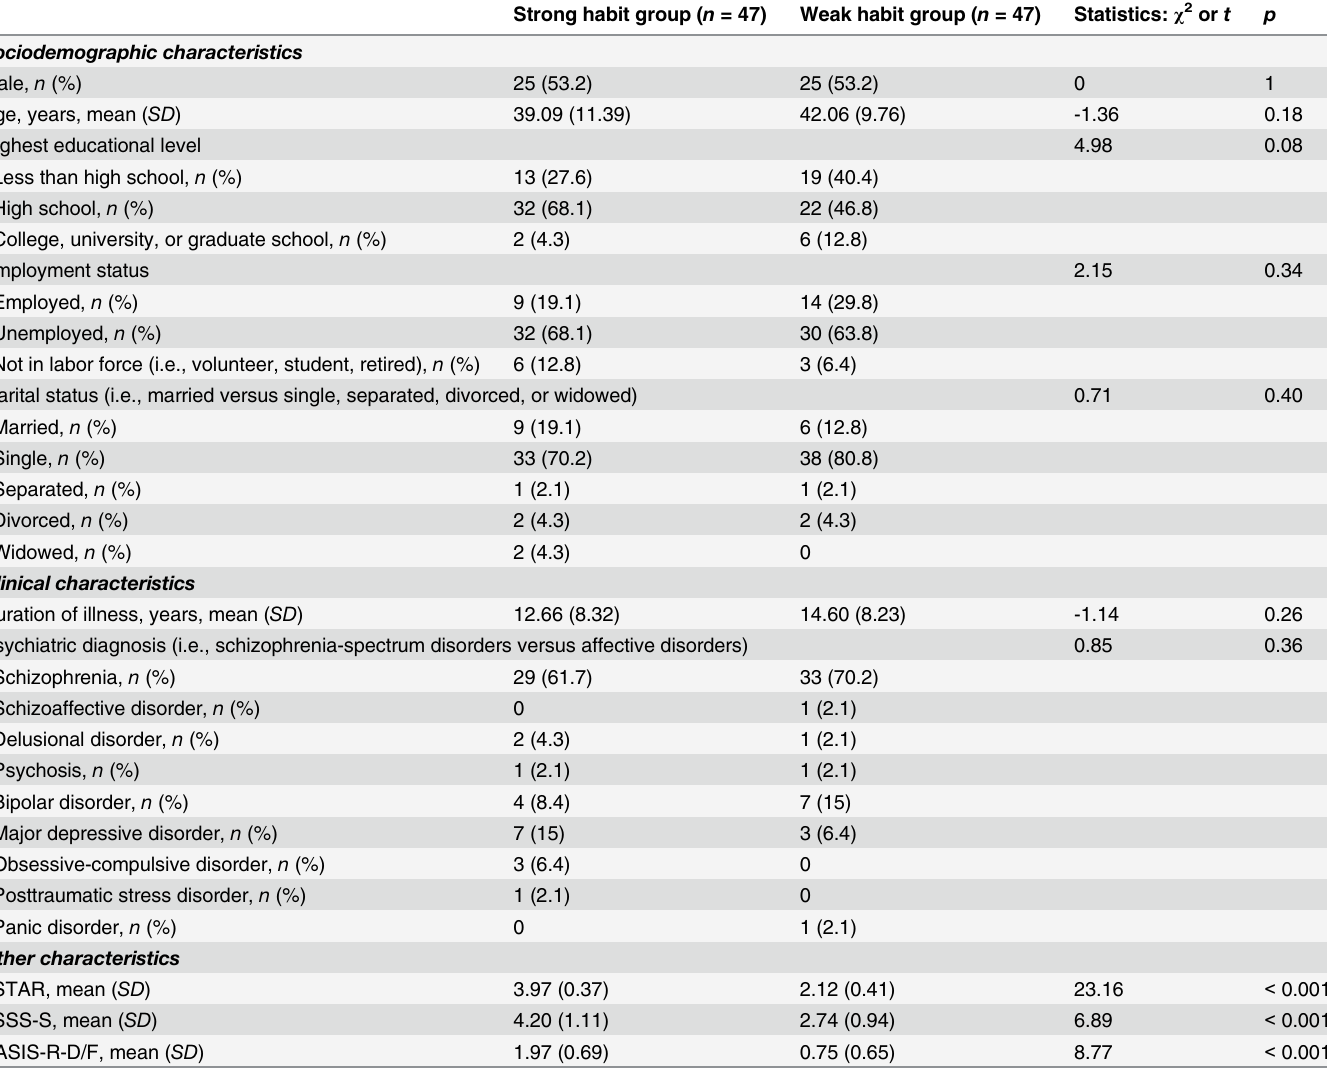
Table 1. Characteristics of participants in the strong and weak habit groups. Strong habit group ( n = 47) Weak habit group ( n = 47) Statistics: χ 2 or t